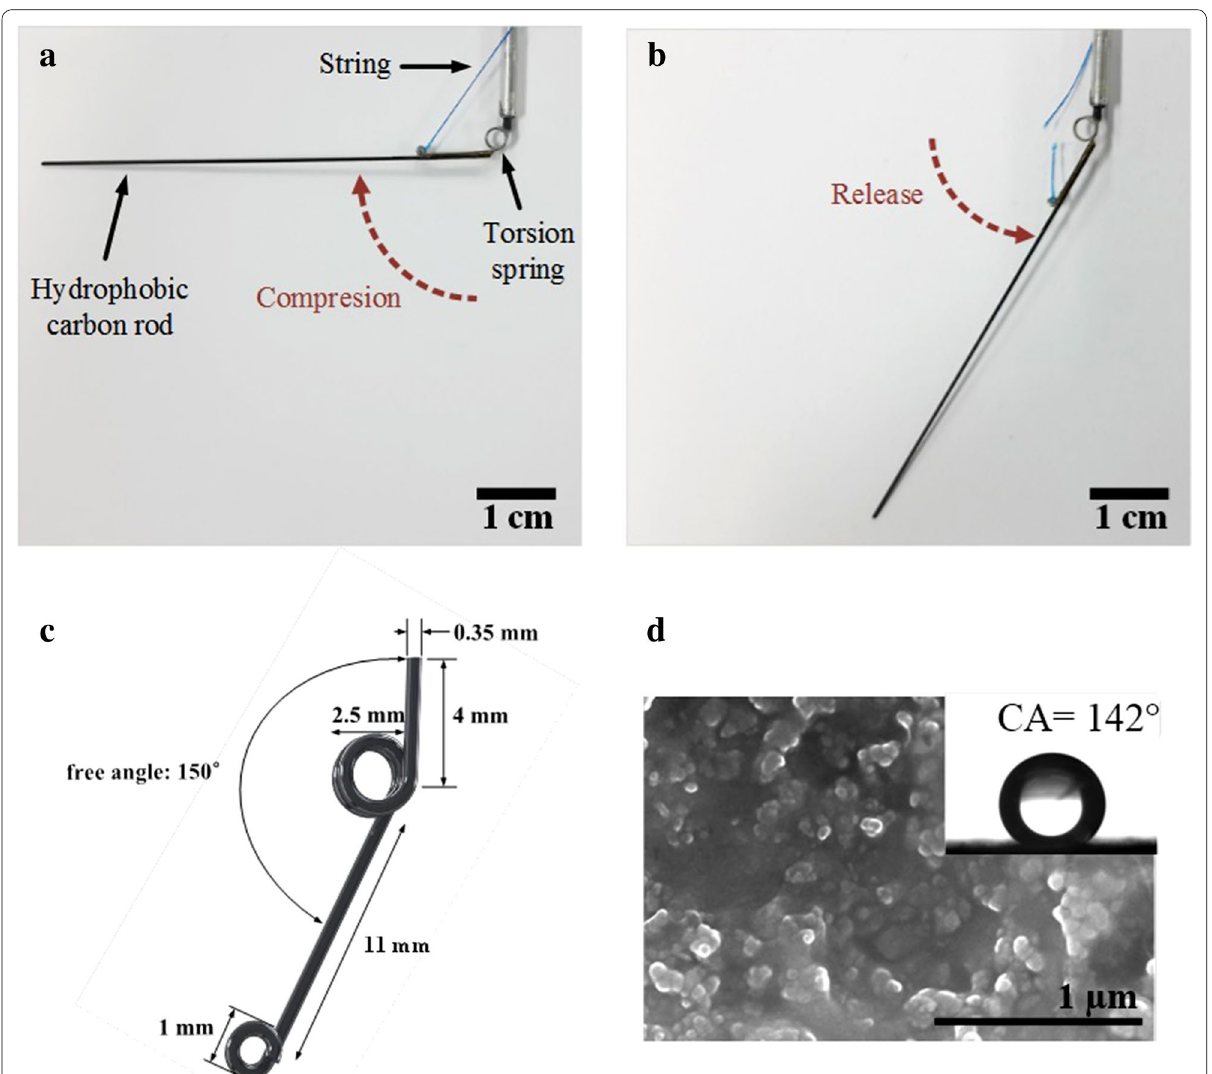
Fig. 2 Photos of the fabricated device in its triggered state ( a ) and released state ( b ). c Dimensions of the torsion spring. d SEM image of the surface of the hydrophobically‑modified carbon rod (contact angle